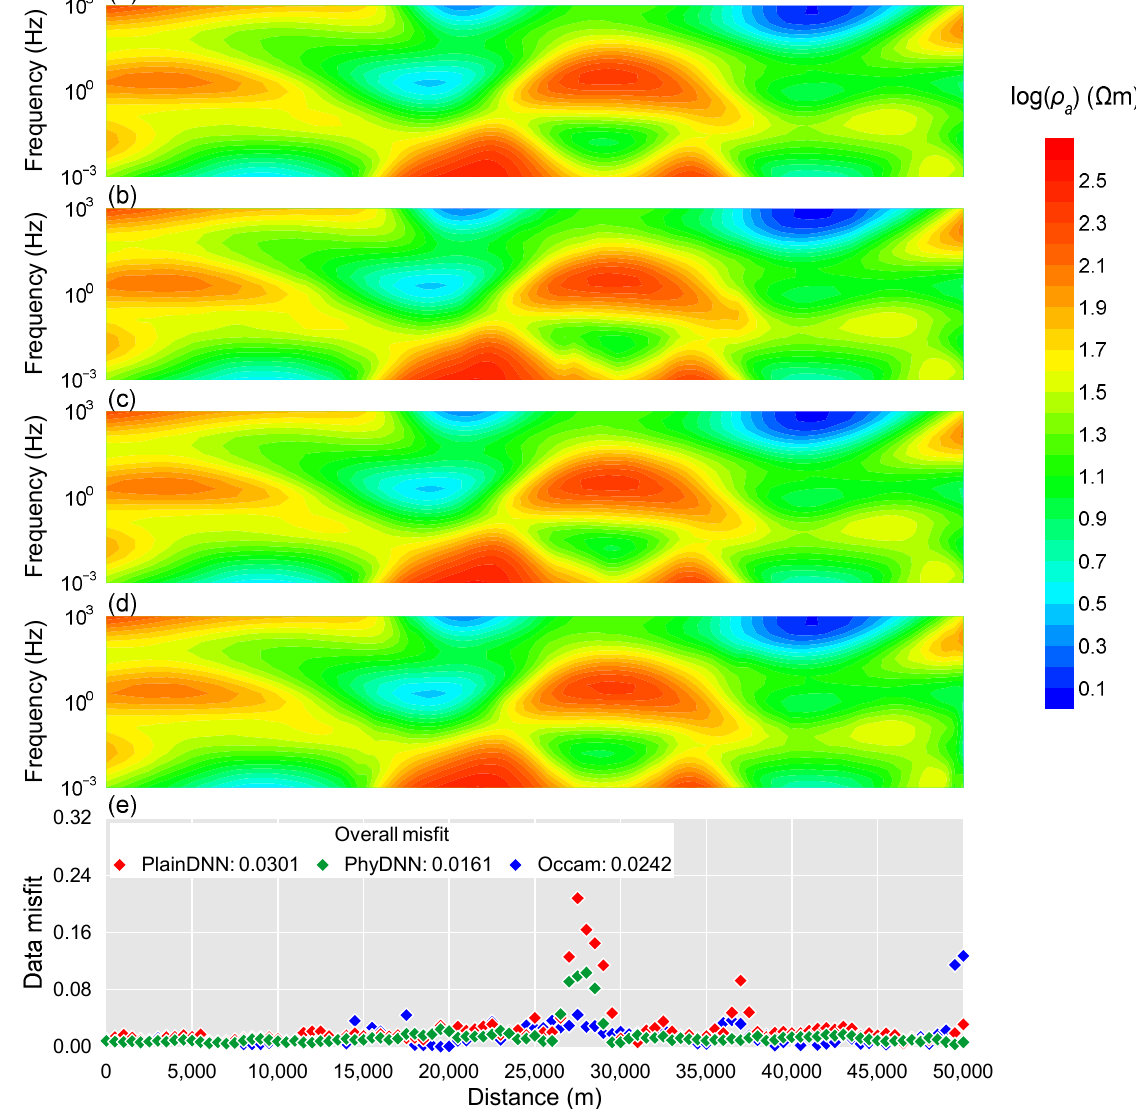
Figure 13. Comparison of the corresponding simulated apparent resistivity sections of the models shown in Figure 12. ( a–d ) are the real apparent resistivity, the simulated apparent resistivity of the PlainDNN, PhyDNN and Occam, respectively. ( e ) shows the individual data misfit for all sites and the overall data misfit of the whole model.